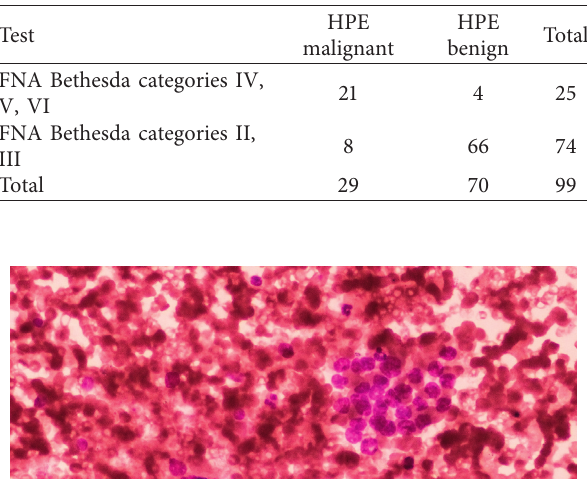
Table 3: Determination of diagnostic values.